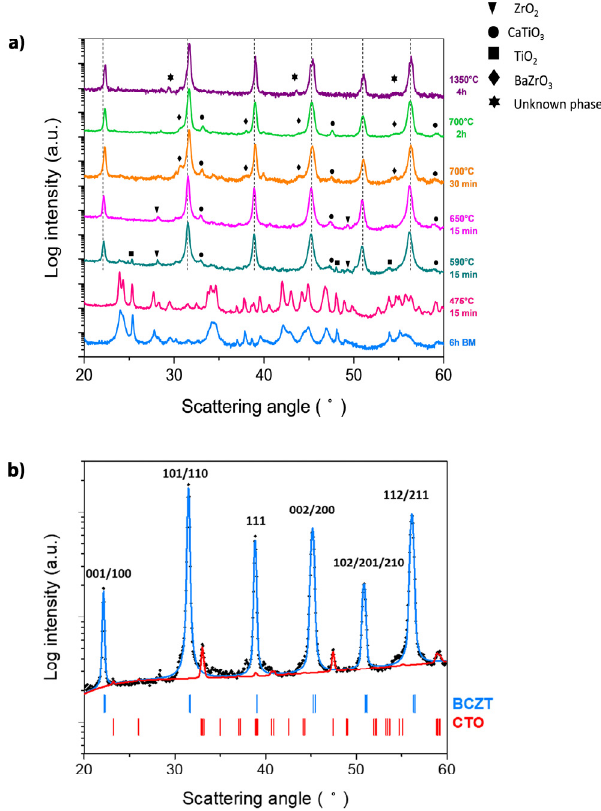
Figure 2. ( a ) XRD diffraction patterns of the powder ball-milled for 6 h and calcined under variable time and temperature. Symbols indicate the secondary phases that accompany the main Barium Calcium Zirconium Titanate (BCZT) perovskite. Vertical dotted lines indicate the main BCZT per- ovskite reflections that are marked with the Miller indexes for the tetragonal prototype. ( b ) Rietveld analysis of the calcined powder at 700 °C for 2 h, in which both BCZT and Calcium Titanate (CTO) stick patterns are shown.